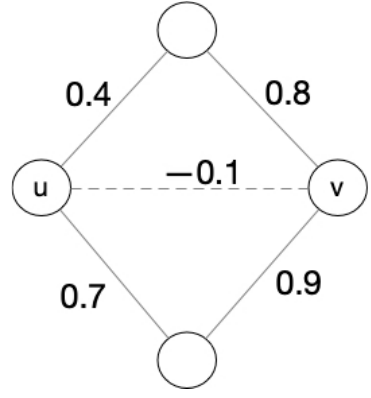
Figure 3. The original graph g .